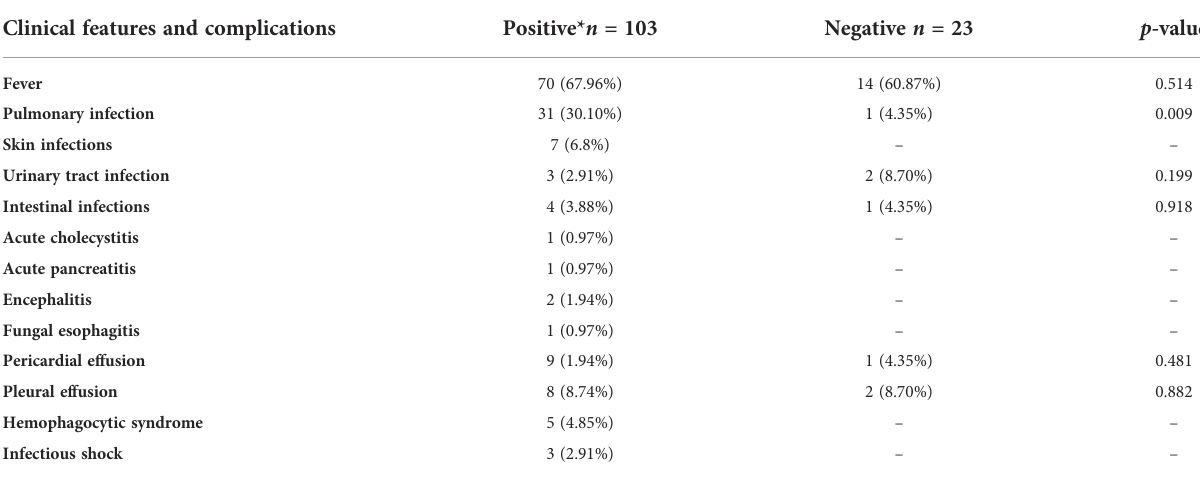
TABLE 2 Clinical features and complications of all patients. Clinical features and